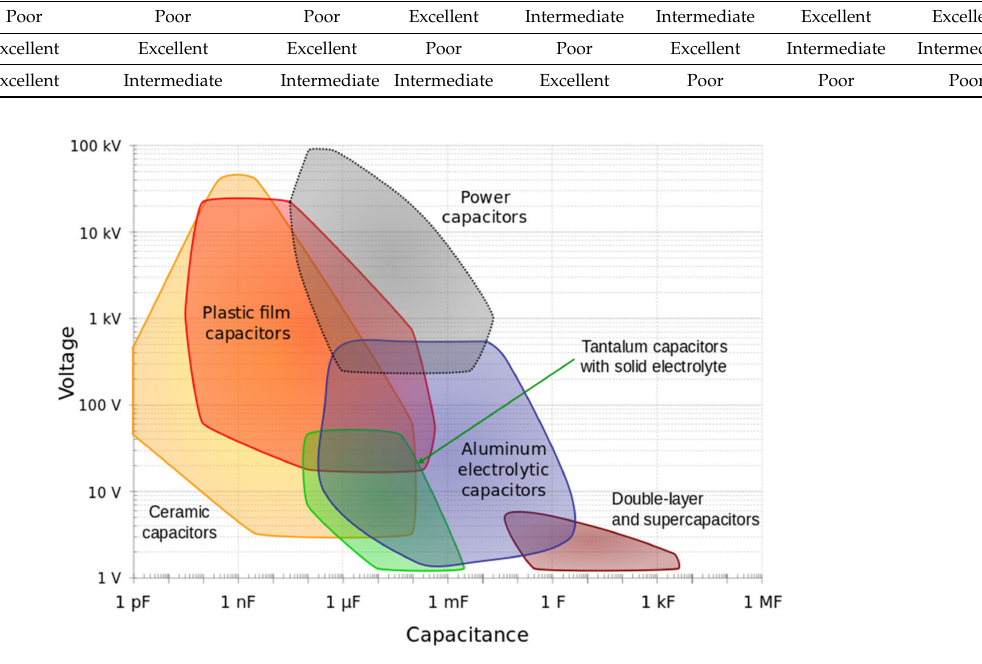
Figure 7. Capacitance ranges vs voltage ranges of different capacitor types